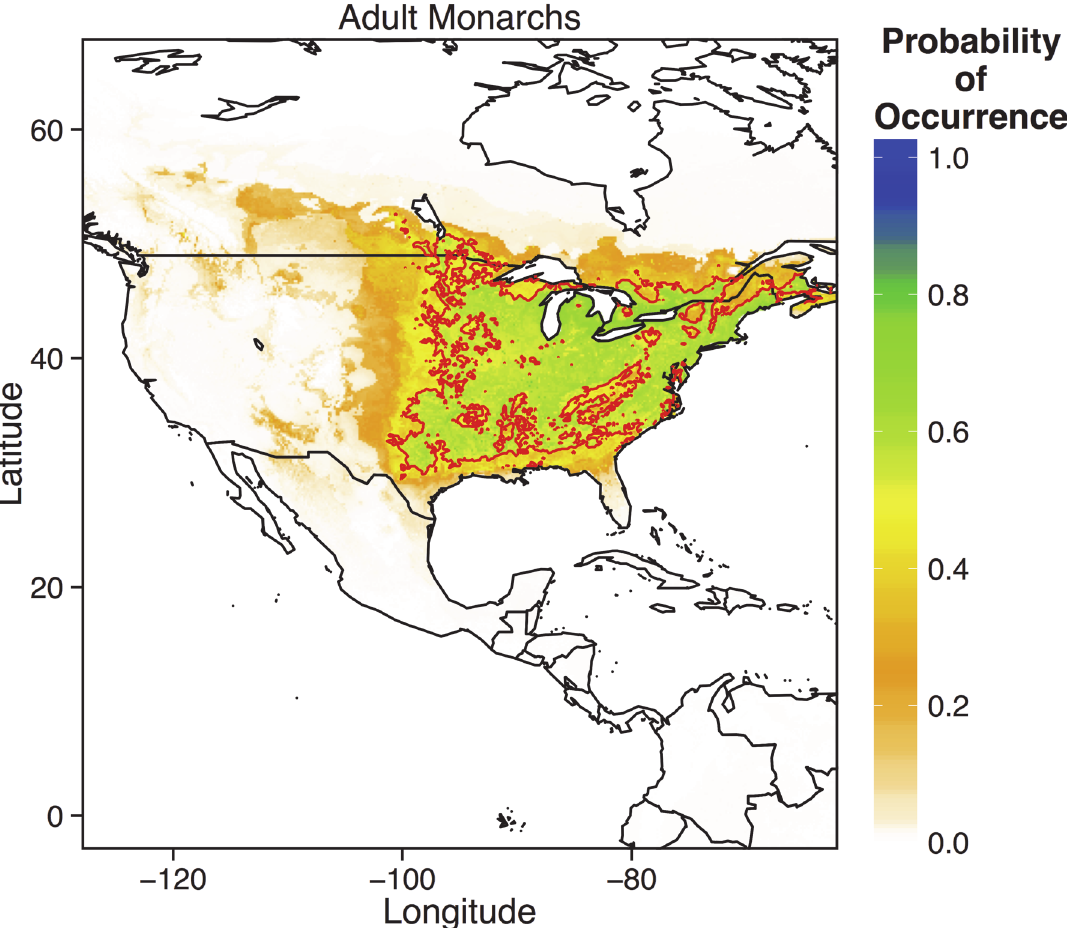
of Asclepias in the Great Lakes region, the monarch ’ s summer breeding grounds of eastern populations, did not occur until May and June (Fig. 8). Under the moderate emissions scenario, suitable area for first sightings of Asclepias was reduced in all months (Fig. 8). Also, Asclepias did not cease expanding northward at the Great Lakes in May, as it currently does, but